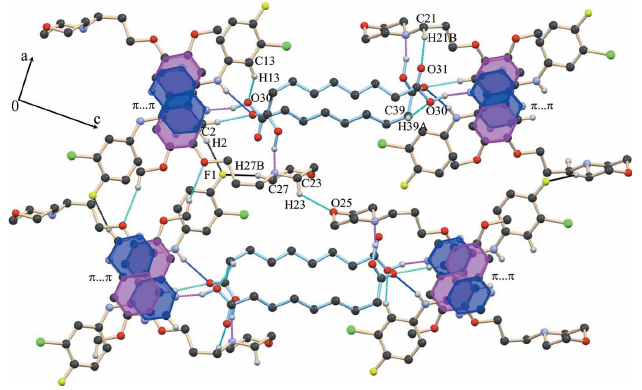
Figure 7 The view of the molecular packing along the b axis showing the association of GTB molecules through aromatic (cid:2) – (cid:2) interactions along with C—H (cid:2)(cid:2)(cid:2) F and C—H (cid:2)(cid:2)(cid:2) O